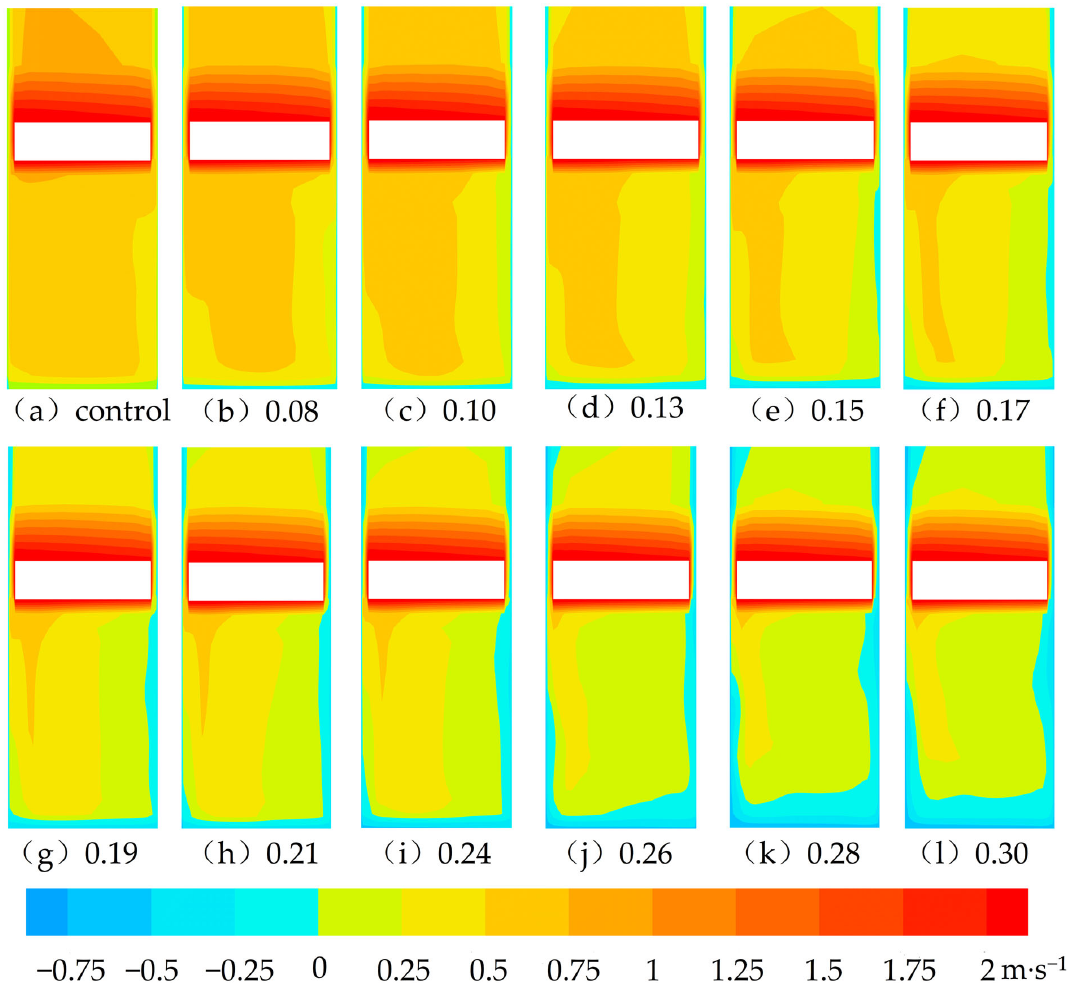
Figure 4. Contour distribution of axial flow velocity in annular flume at different speed ratios, where ( a ) is the control group driven by the shear ring only; ( b – l ) are the different working conditions obtained by different turn–continuity ratios.